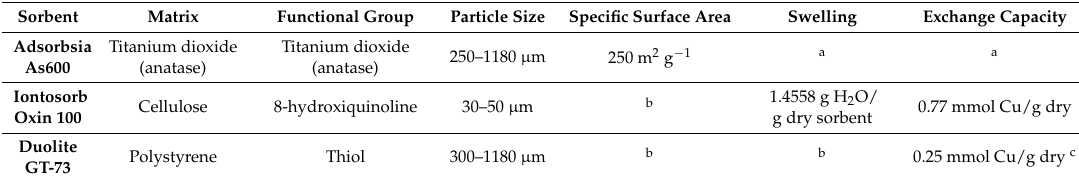
Table 1. Physicochemical characteristics of the sorbents used in this